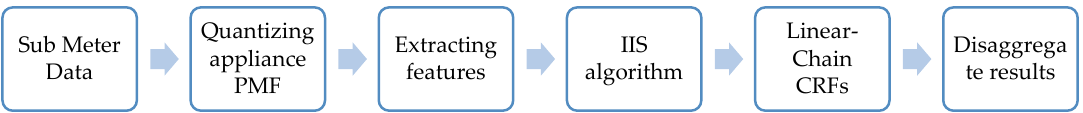
Figure 1. Aggregated load data acquired from smart meters and disaggregating results produced from the model.